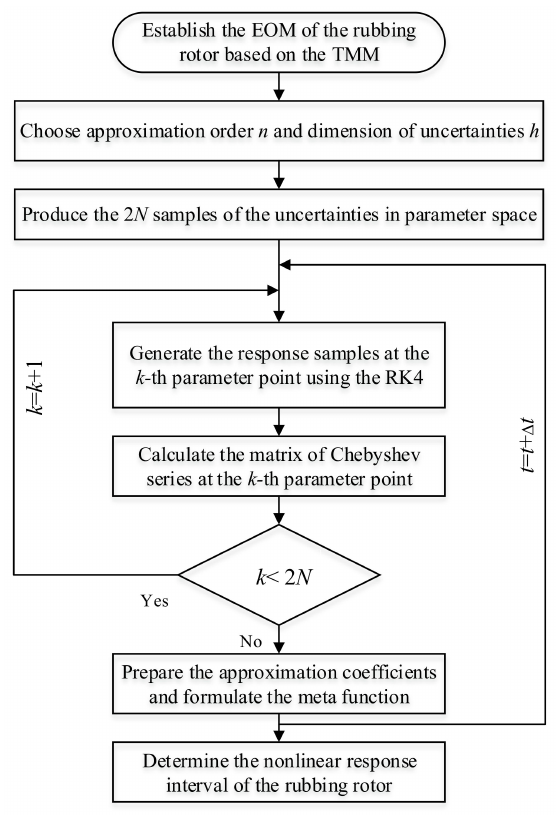
Figure 4. Computational flowchart of the analysis framework. EOM = equations of motion; TMM = transfer matrix method; RK4 = fourth order Runge-Kutta